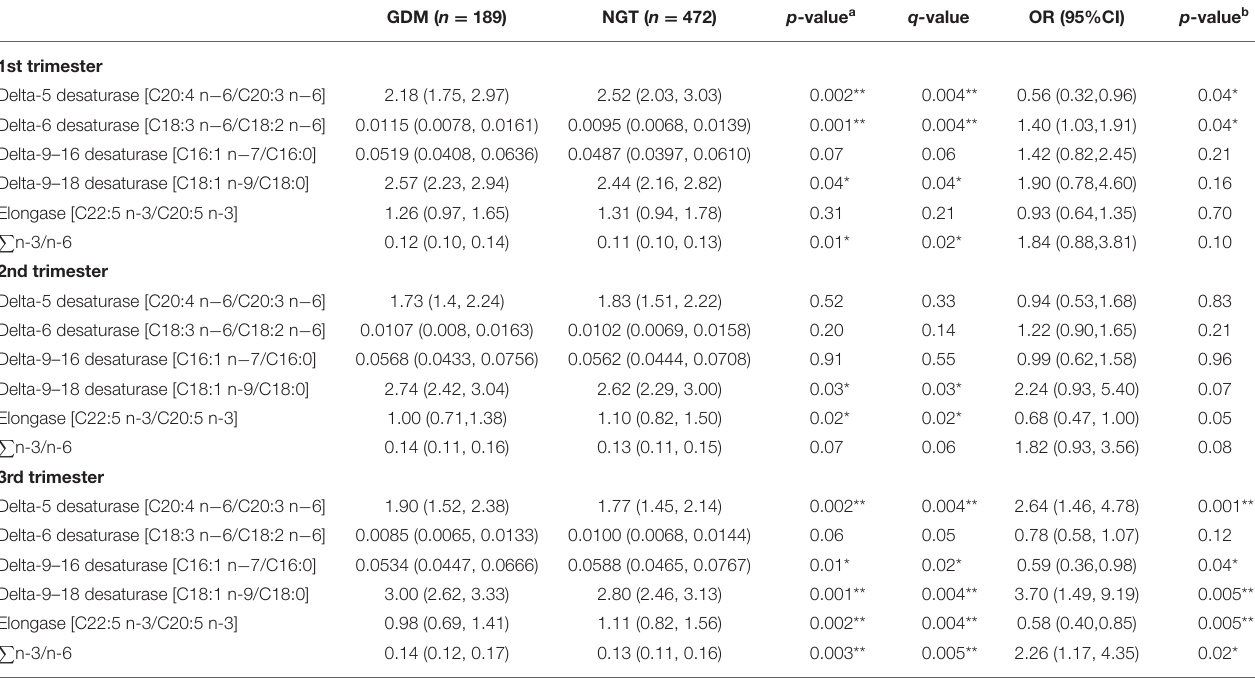
TABLE 2 | Desaturase activities and odds ratios in the first, second, and third trimesters between pregnant women with normal glucose tolerance (NGT) and gestational diabetes mellitus (GDM). GDM ( n = 189) NGT ( n = 472) p -value a q- value OR (95%CI) p -value b